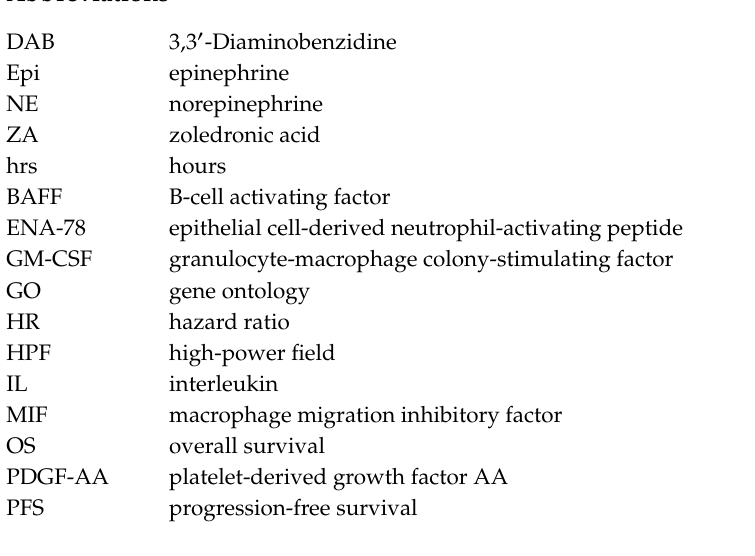
Table S1: Significantly upregulated cytokines in 24 h Epi- or NE-treated SKOV3ip1 monocultures (adjusted for untreated monocultures), Table S2: Significantly upregulated cytokines in 24 h Epi- or NE-treated co-cultures (adjusted for treated monocultures), Table S3: Significantly upregulated cytokines in 24 h Epi- or NE-treated ovarian cancer cell / macrophage co-cultures, Table S4: Top five gene ontology biological processes enriched from di ff erentially regulated cytokines after adrenergic stimuli, Table S5: KEGG pathway analysis of enriched signaling networks from di ff erentially regulated cytokines after adrenergic stimuli, Table S6: Raw cytokine expression data for monoculture and